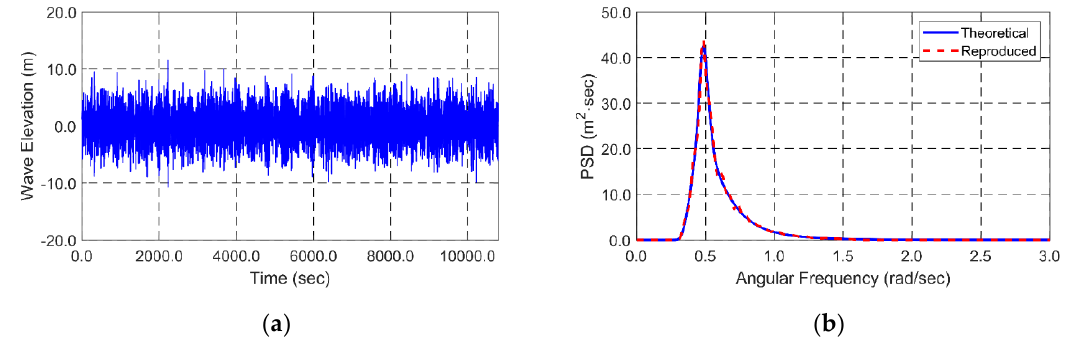
Figure 3. Wave time histories produced by JONSWAP wave spectrum ( a ) and theoretical JONSWAP wave spectrum and reproduced spectrum from wave time histories using FFT (fast Fourier transform) for validation ( b ).